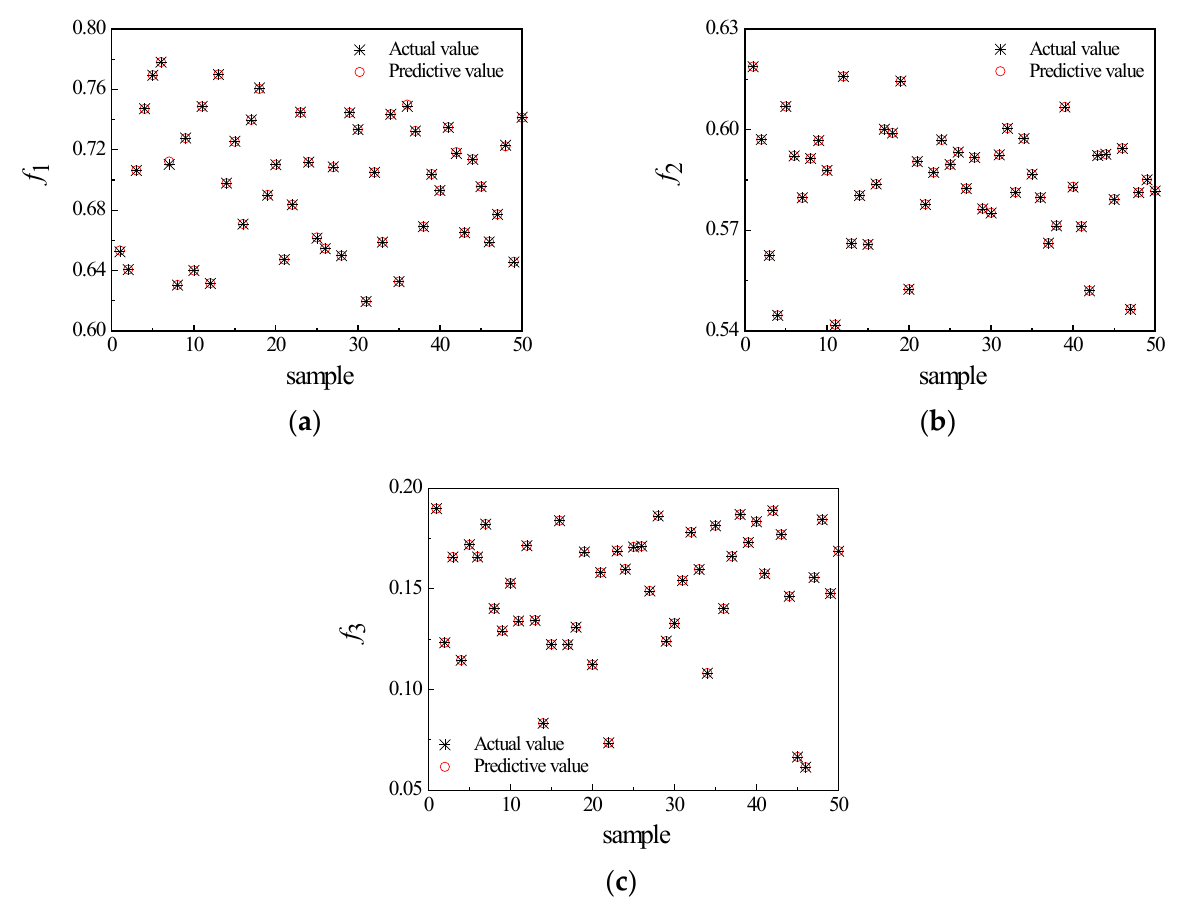
Figure 18. Model test results. ( a ) Model 1; ( b ) Model 2; ( c ) Model 3.